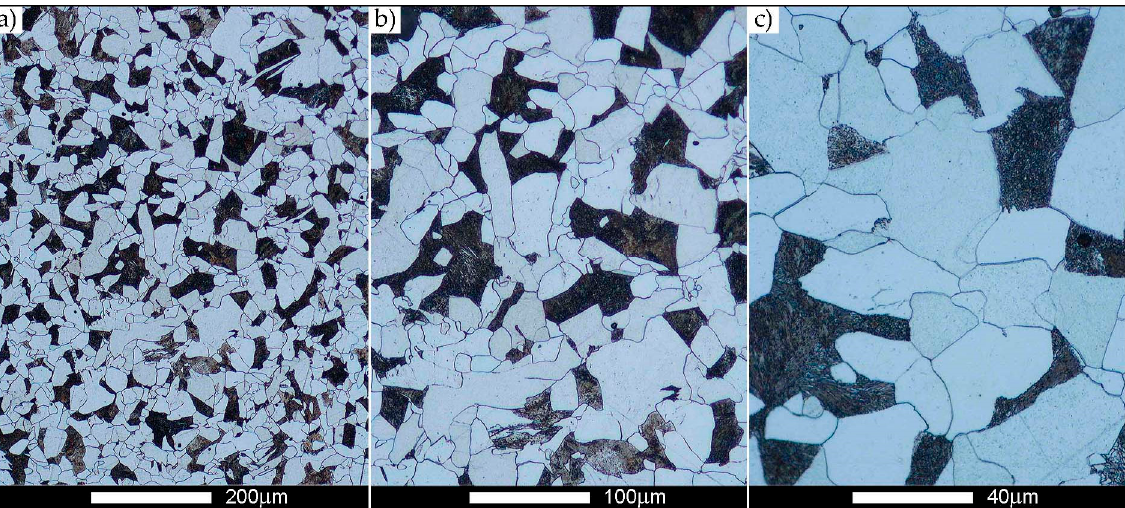
Figure 26. Welded joint microstructure of Hardox 450 steel with revealed grain boundaries of prior austenite, austenitised at 1100 °C—BM zone shown in Figure 2. ( a ) 100×; ( b ) 200×; ( c ) 500×.